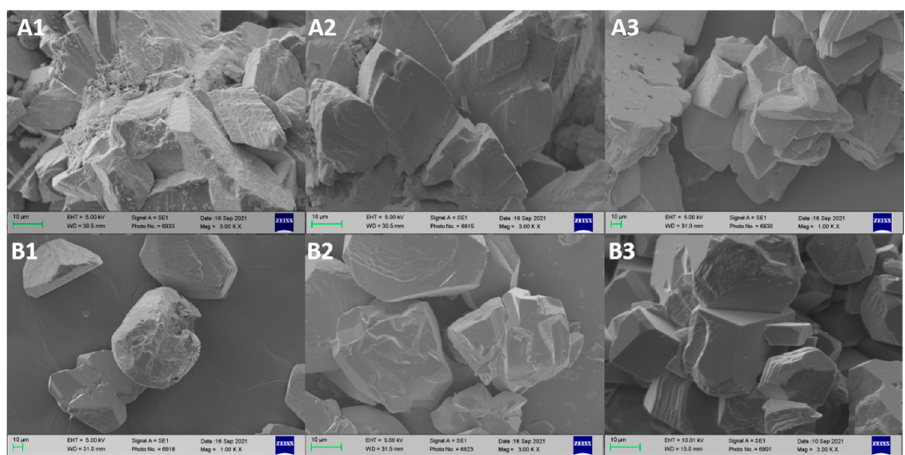
Figure 6. SEM imaging of the crystals (scale bar is 10 µ ). The order of the images corresponds to the decrease in Mg content of calcite. ( A1 – A3 ) correspond to calcite crystals collected from experiments 9A, 9B, and 11E respectively and are crystals with higher Mg content and sharper crystal edges. Comparatively, ( B1 – B3 ) which correspond to calcite crystals collected from experiments 10A, 9D, and 11AA respectively poses lower Mg content and truncated crystal